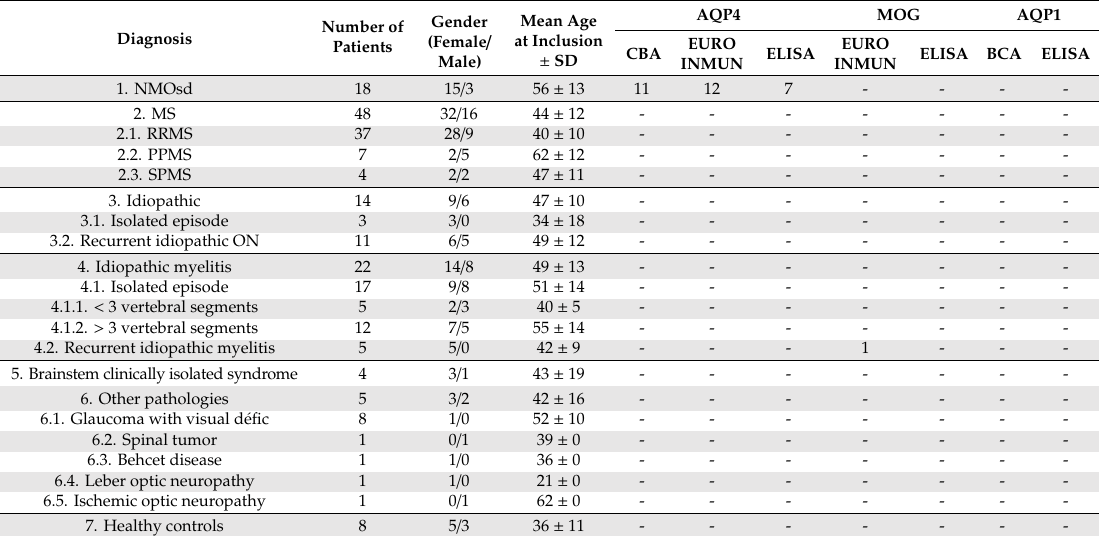
Table 1. Demographic and clinical variables of 119